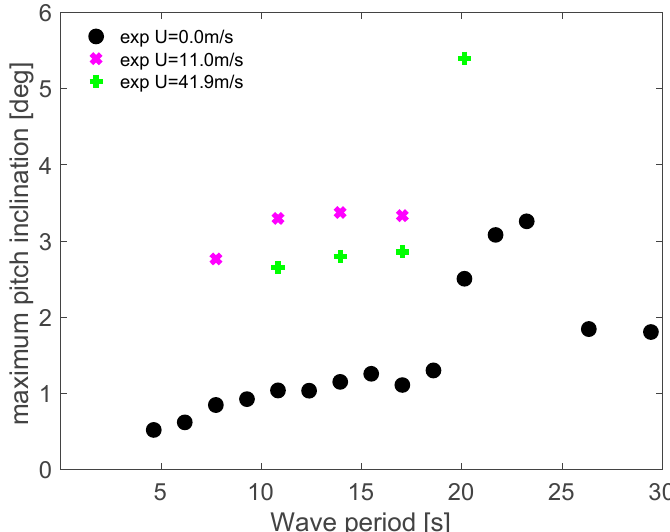
Figure17. E ff Figure 17. Effect of the incident wind speed on the experimental maximum pitch inclination angle